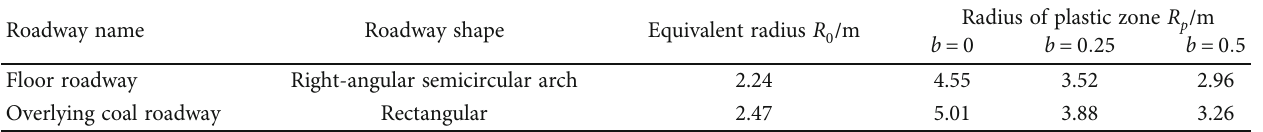
Table 2: Radius of plastic zone in the roadway under di ff erent principal stress coe ffi cients.